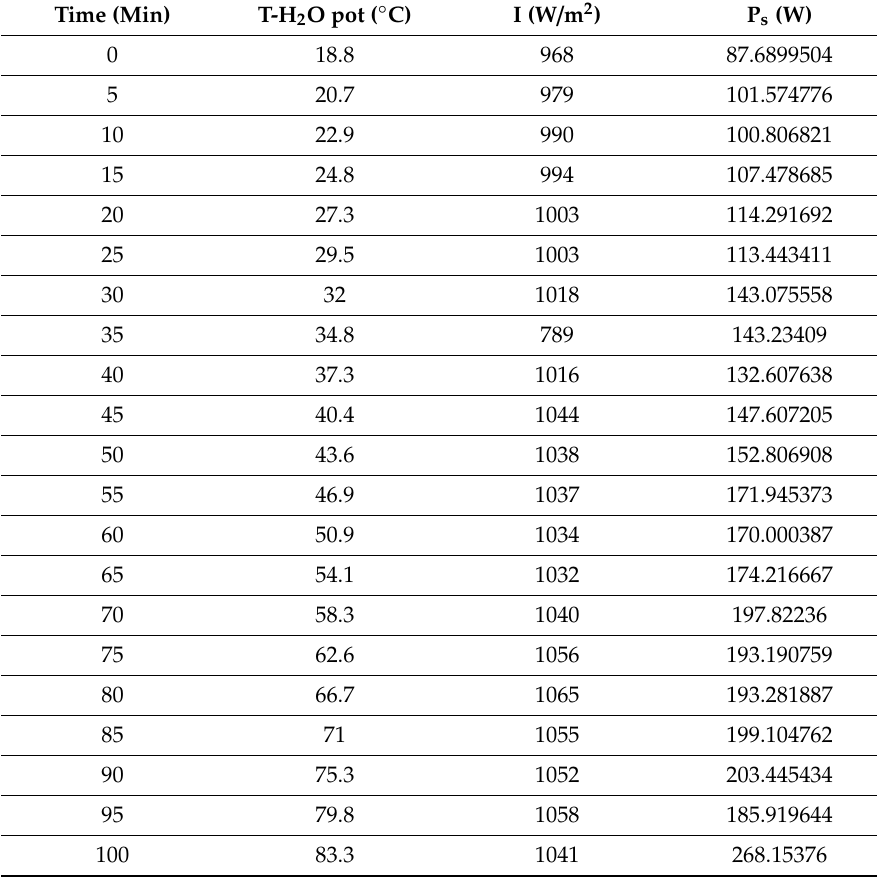
Table A2. Experimental measures to calculate standardized cooking